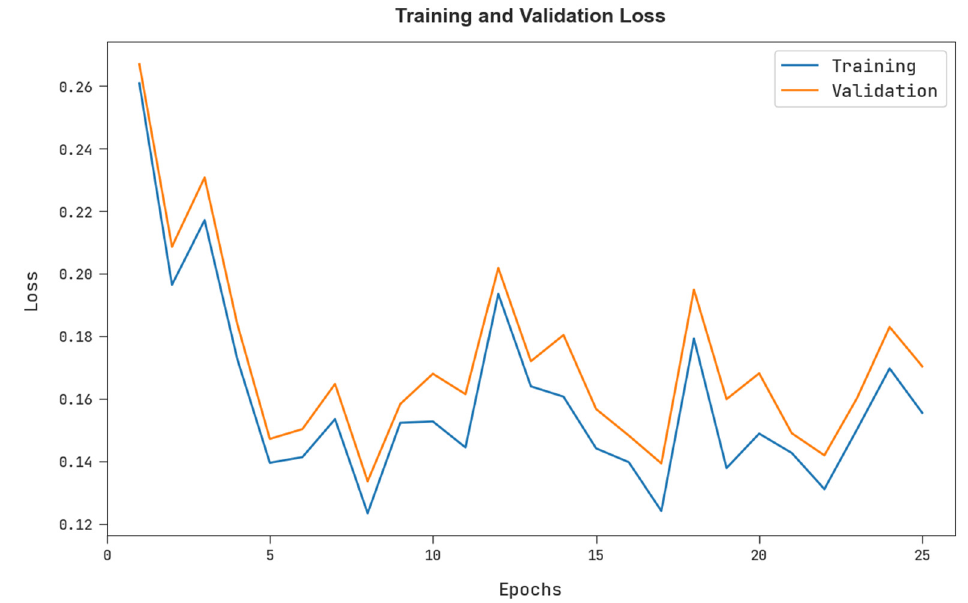
Figure 9. TRL and VLL analysis of FSHDBN-CID algorithm.